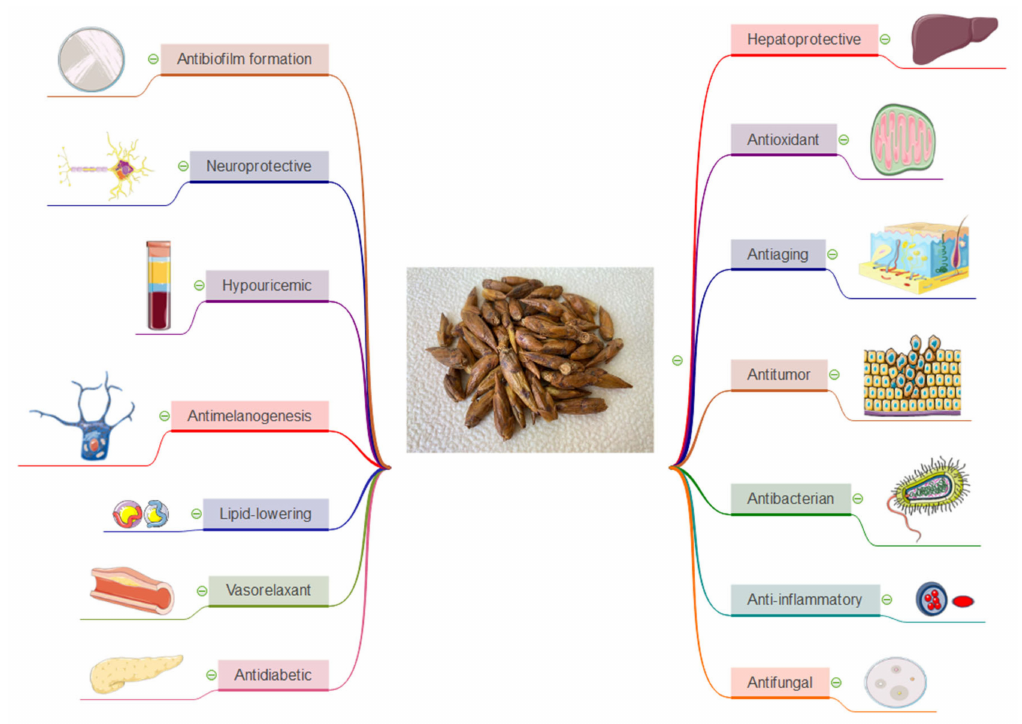
Figure 2. A brief overview of the therapeutic uses of Populus nigra L.